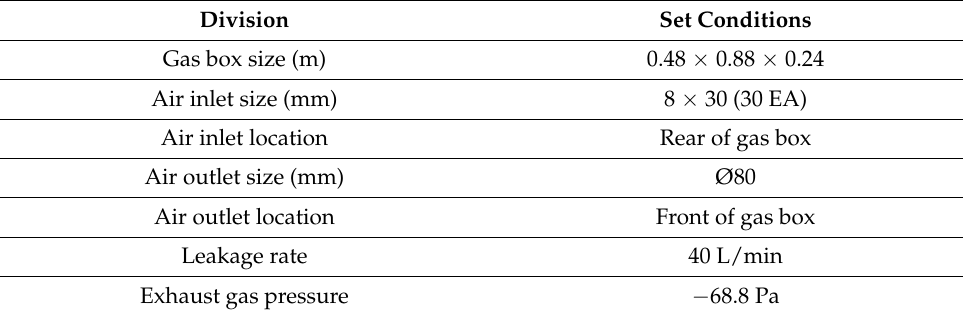
Figure 4. Air inlet, air outlet, and gas inlet. Table 3. CFD simulation parameters.